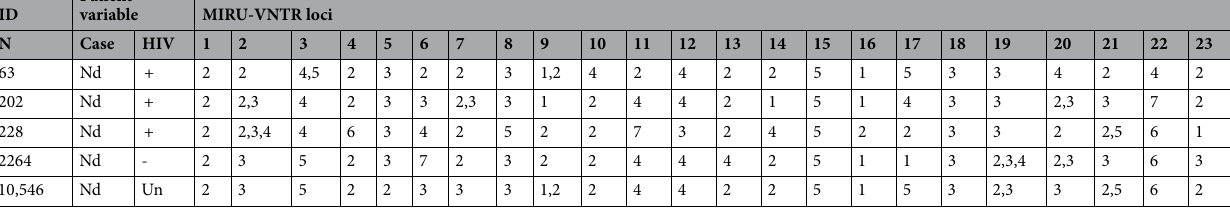
Table 2. Patients in south western Uganda harboring more than one strain of M. tuberculosis identified using MIRU-VNTR standardized 24 loci. The numerical figures represent the number of alleles per amplified MIRU- VNTR loci, as described by Supply et al. 28 . Where there is more than one numerical figure per locus indicates existence of more than one MTB strain in the sample, signifying an infection with multiple strains of M. tuberculosis . MIRU-VNTR Loci: 1 = 154, 2 = 424, 3 = 577, 4 = 580, 5 = 802, 6 = 960, 7 = 1644, 8 = 1955, 9 = 2059, 10 = 2163b, 11 = 2165, 12 = 2347, 13 = 2401, 14 = 2461, 15 = 2531, 16 = 2687, 17 = 2996, 18 = 3007, 19 = 3171, 20 = 3192, 21 = 3690, 22 = 4052, 23 = 4156, 24 = 4348. ID patient identification number, Nd Newly diagnosed, Un unknown.